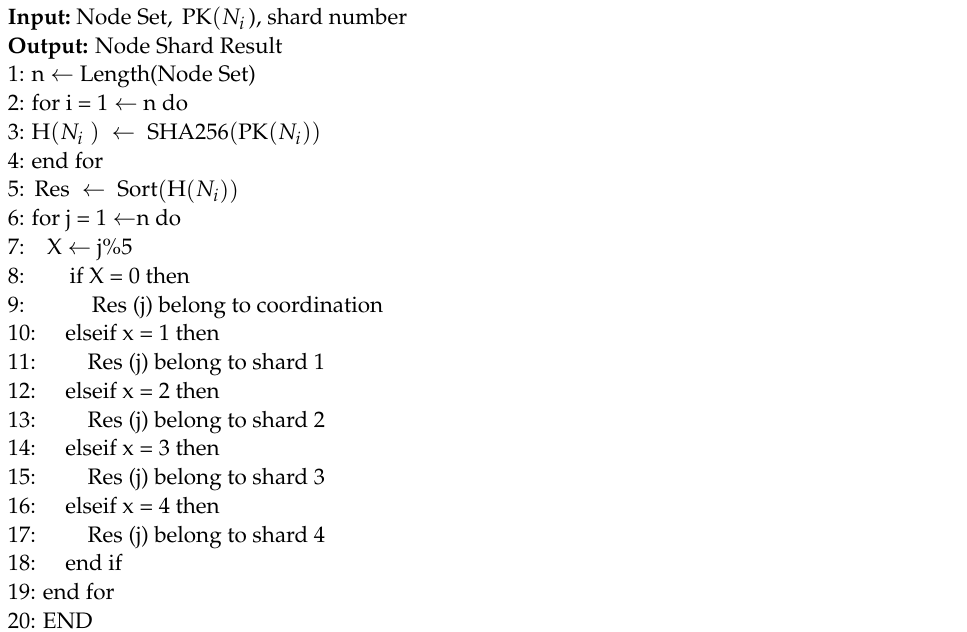
Algorithm 1 Pseudo-Code of the Node